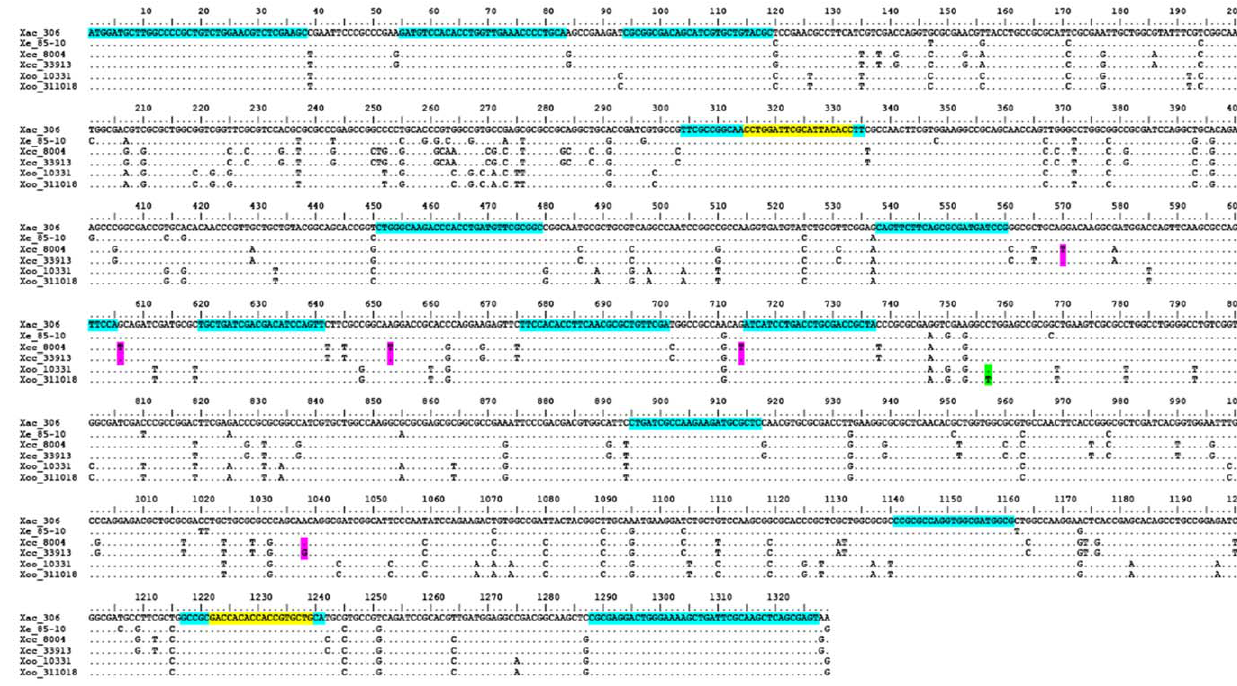
Figure 1. Alignment of the dnaA gene from six Xanthomonas strains. The dnaA genes of X. campestris pv. campestris strains differ by 5 SNPs (pink highlight) and those of two X. oryzae pv. oryzae strains (green highlight) differ by 1 SNP. Conserved 20 + -mers in all six Xanthomonas genomes are highlighted in blue. The only set of primers that flank all SNPs, have a melting temperature of 60 6 2 u C and a G + C content of 50–60%, end in a G or C and have no complementary bases at the ends, are highlighted in yellow.